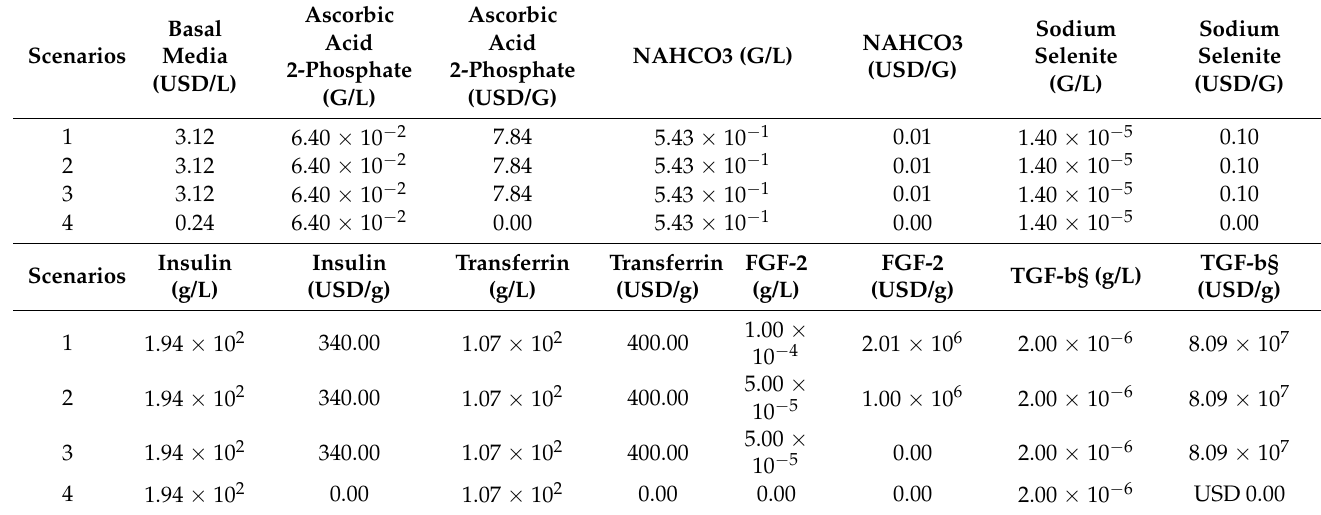
Table A3. Model variable inputs: Media.